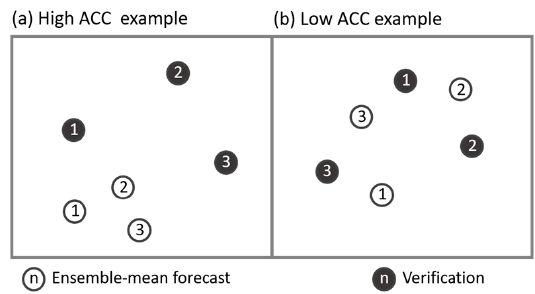
Figure 2. A schematic describing forecast groups with ( a ) high and ( b ) low anomaly correlation coefficient skill. The open circles are the forecasts and the filled circles are the verifications. The number on them denotes the time segment label.